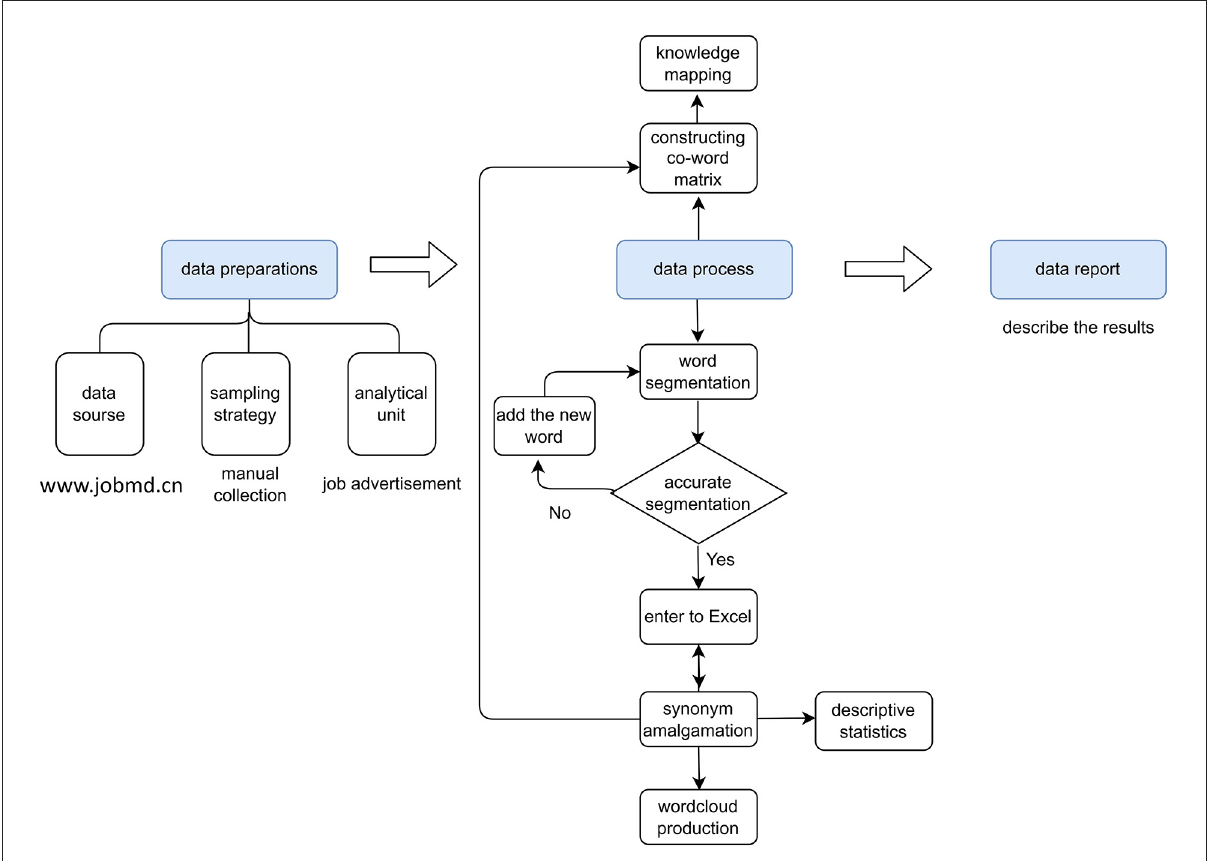
FIGURE1 The content analysis process (Edited in 2021/4,